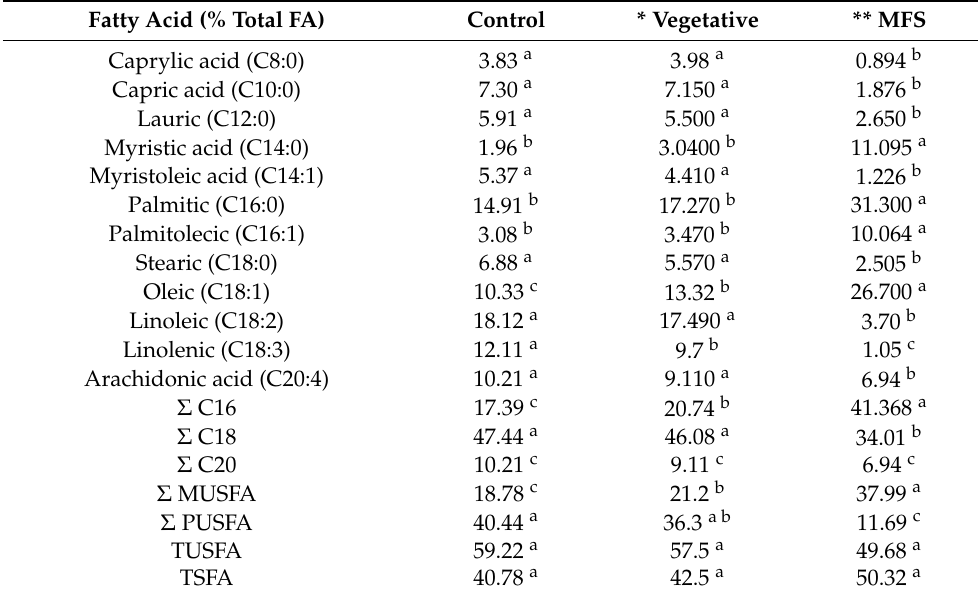
Table 2. GC/MS chromatogram of fatty acid methyl ester of Nannochloropsis oculata grown under vegetative and multifactor stress conditions (BSA, NaCl, and nitrogen